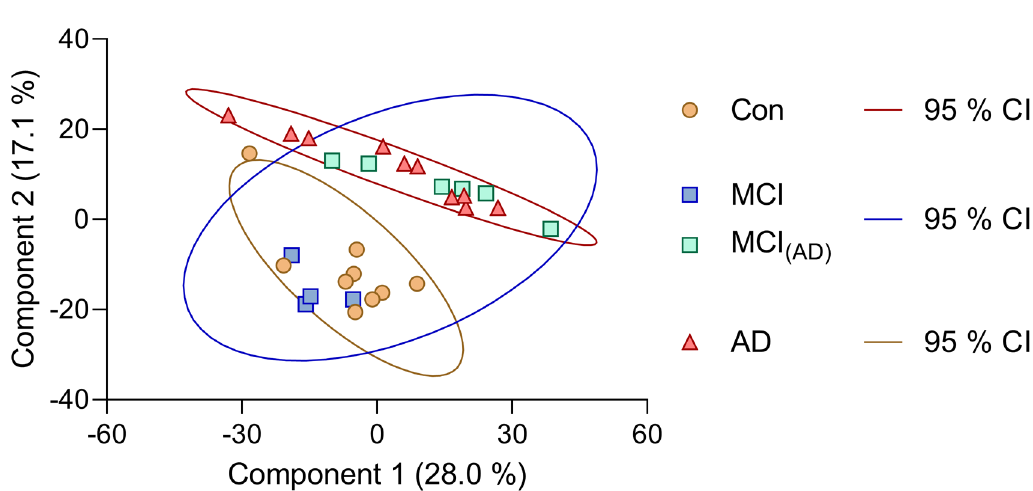
Figure 3. Scores plot with principal component analysis (PCA) results reveals samples clustering according to their groups; AD patients (red triangles), healthy controls (orange circles), and MCI patients. MCI patients cluster along with both the AD group (green squares, MCI (AD) ) and control group (blue squares) indicating similarities with both groups. The corresponding 95 % confidence interval (CI) for the groups is indicated by the